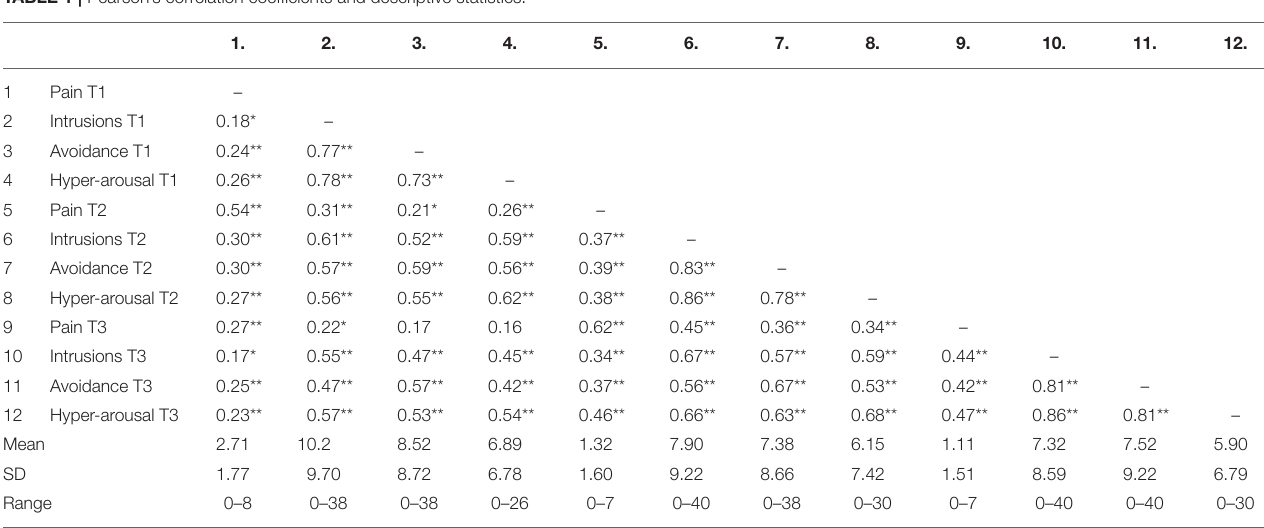
TABLE 1 | Pearson’s correlation coefficients and descriptive